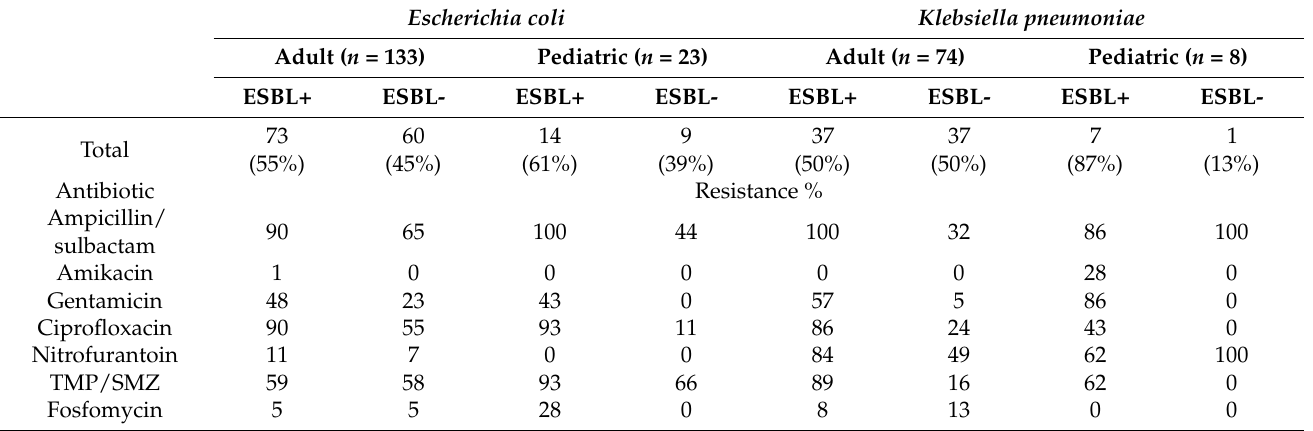
Table 4. Resistance in Escherichia coli and Klebsiella pneumoniae isolates from adult and pediatric patients according to ESBL *